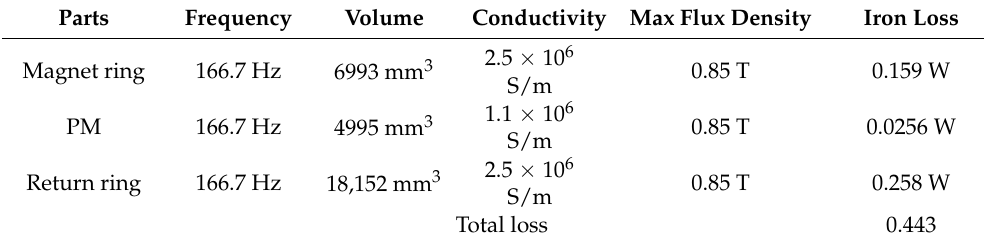
Table 7. Other parameters and loss calculation results of the AMB.